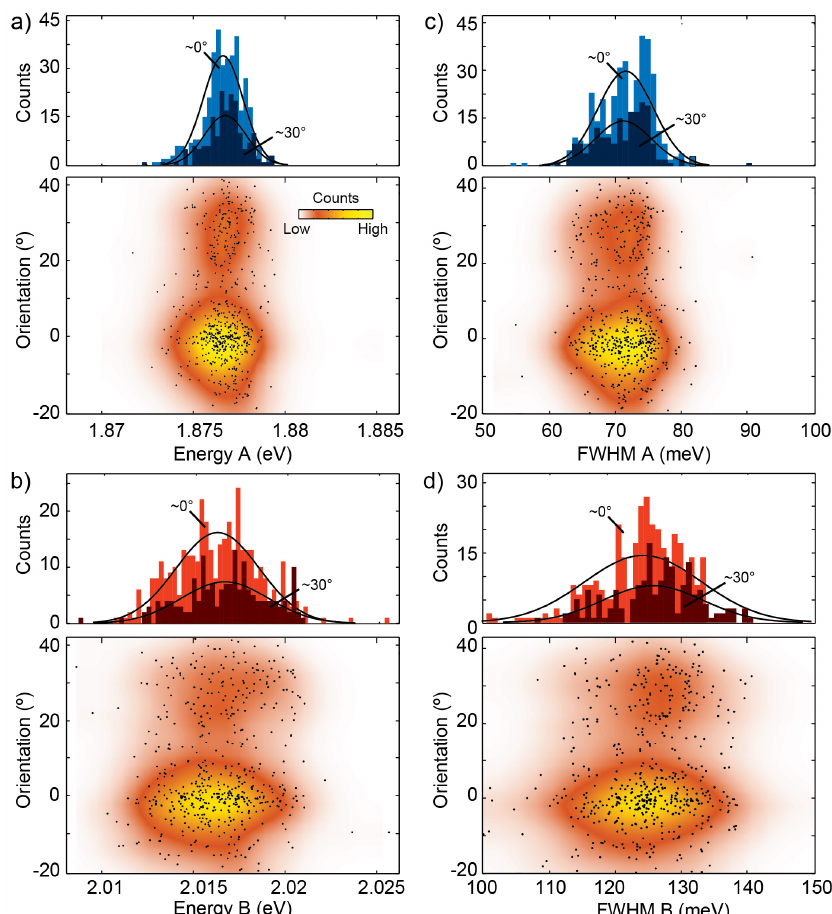
Figure 4. ( a ) Density plot of the triangle orientation as a function of the A exciton energy. (top) Conditional histograms of the A exciton energy for triangles with orientation 0° ± 10° (light blue) and triangles with orientation 30° ± 10° (dark blue). ( b ) Same as panel (a) for exciton B. ( c ) Density plot of the triangle orientation as a function of the A exciton peak FWHM. (top) Conditional histograms of the A exciton peak FWHM for triangles with orientation 0° ± 10° (light blue) and triangles with orientation 30° ± 10° (dark blue). ( d ) Same as panel (c) for exciton B.